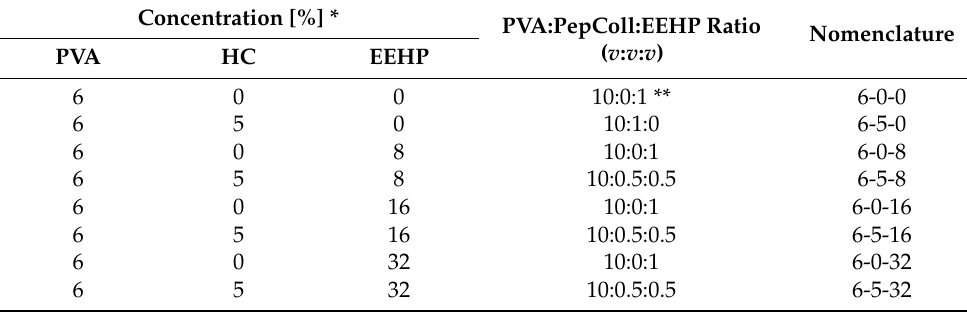
Table 1. Nomenclature of the fabricated membranes.